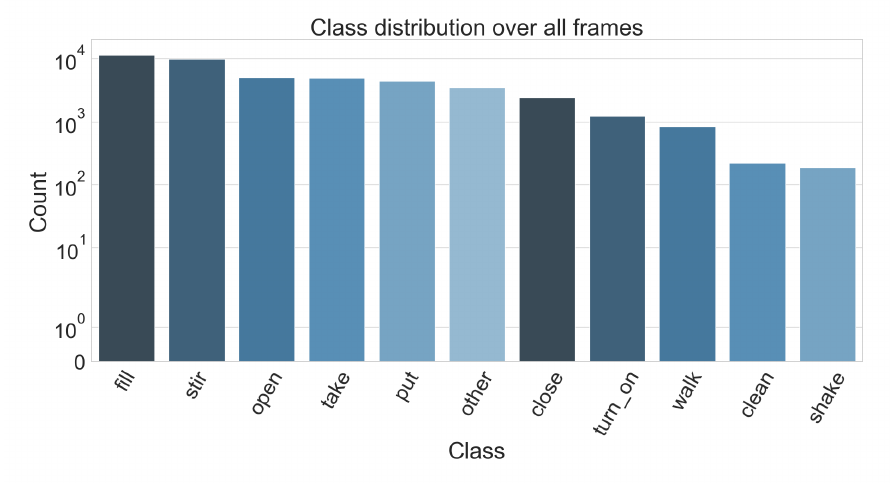
Figure 5. Distribution of the classes we consider from the CMU-MMAC dataset using the annotations from [18]. The class label is derived from the verb part of the original